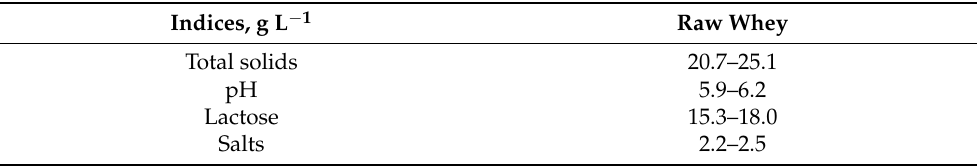
Table 2. Physical–chemical characteristics of pre-concentrated commercially obtained mixed whey used as a carbon source for the production of lactobionic